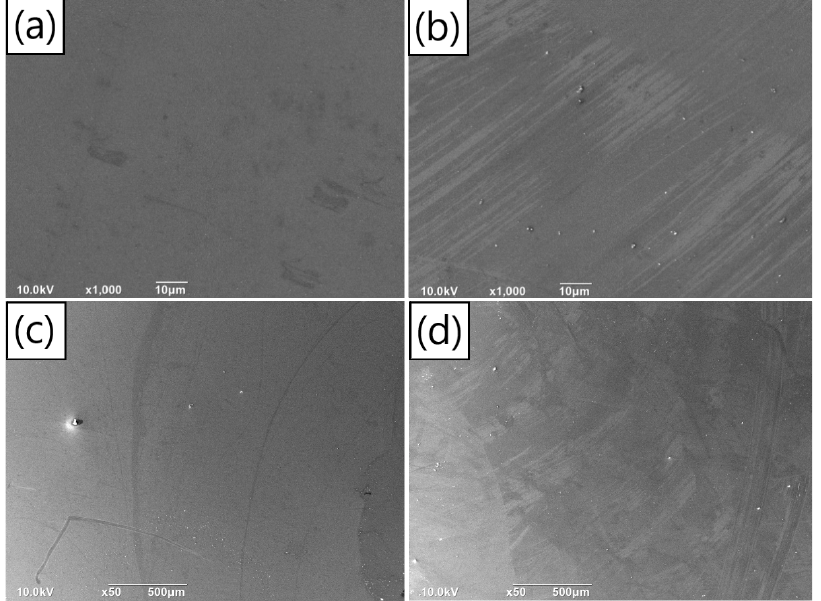
Figure 7. Surface SEM images (1000 × ) of the same thickness PDA films prepared with different deposition time on silicon dioxide substrates under the concentrations of ( a ) 1.5 mg/mL and ( b ) 2 mg/mL; surface SEM images (50 × ) of the same thickness PDA films fabricated with different deposition time on silicon dioxide substrates under the concentrations of ( c ) 1.5 mg/mL and ( d ) 2 mg/mL.